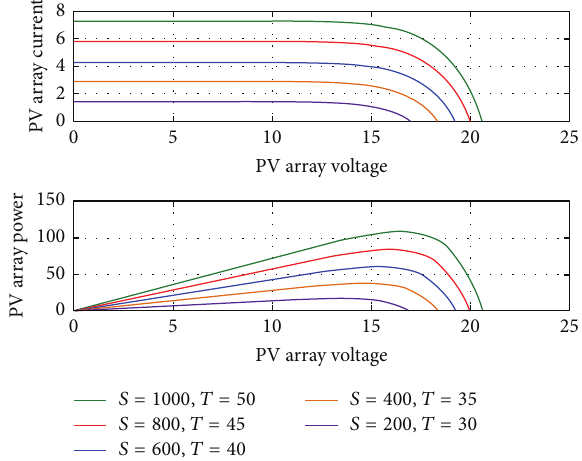
Figure 1: Internal equivalent diagram of photovoltaic panel. Figure 2: